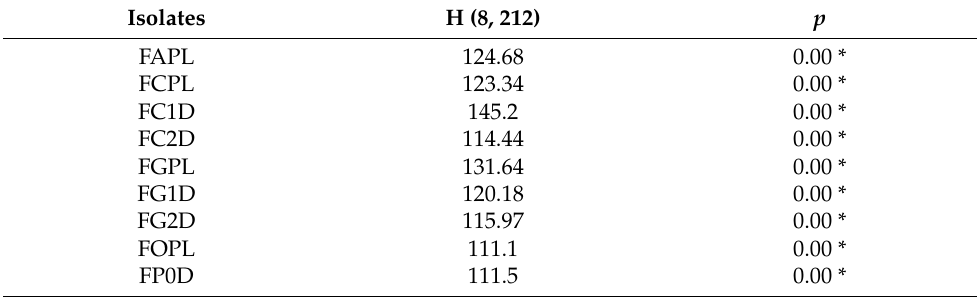
Table 1. Results of Kruskal–Wallis test. Comparison of the index of linear growth of mycelial isolate in presence of used essential oils.